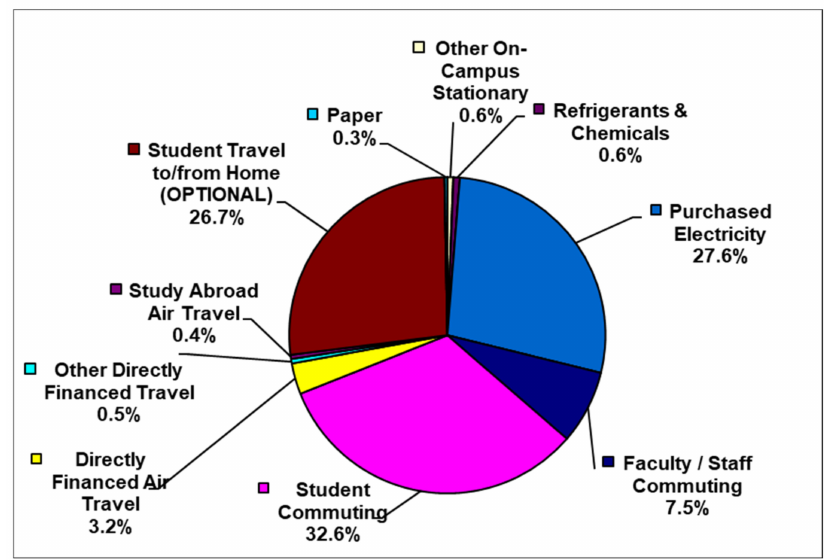
Figure 3. Detailed contribution of every factor to the University of Patras’s carbon footprint.